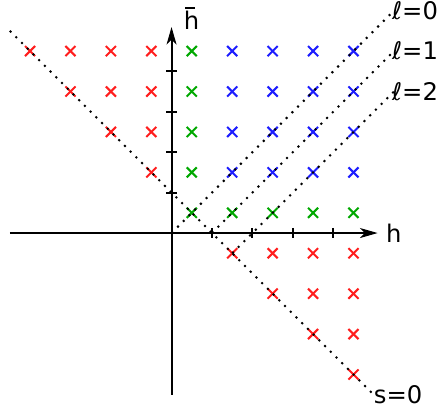
Figure 3 . This diagram shows the arrangement of spurious poles that we meet in deforming the contour of integration in the direction of increasing Re h; e h . The red poles (with h or e h negative) are poles of the conformal block F h ( (cid:31) ) F ( (cid:31) ), and the blue and green ones (with h; e h positive) are e h poles of ( h; e h ). With the exception of the poles on the line ‘ = 0, which have to be treated more A carefully, red and blue poles are related in pairs by h 1 h or by e h 1 e h , but not both. $ (cid:0) $ (cid:0) A cancellation occurs between these pairs. Green poles on the lines h = 1 = 2 and e h = 1 = 2 do not contribute because the measure factor